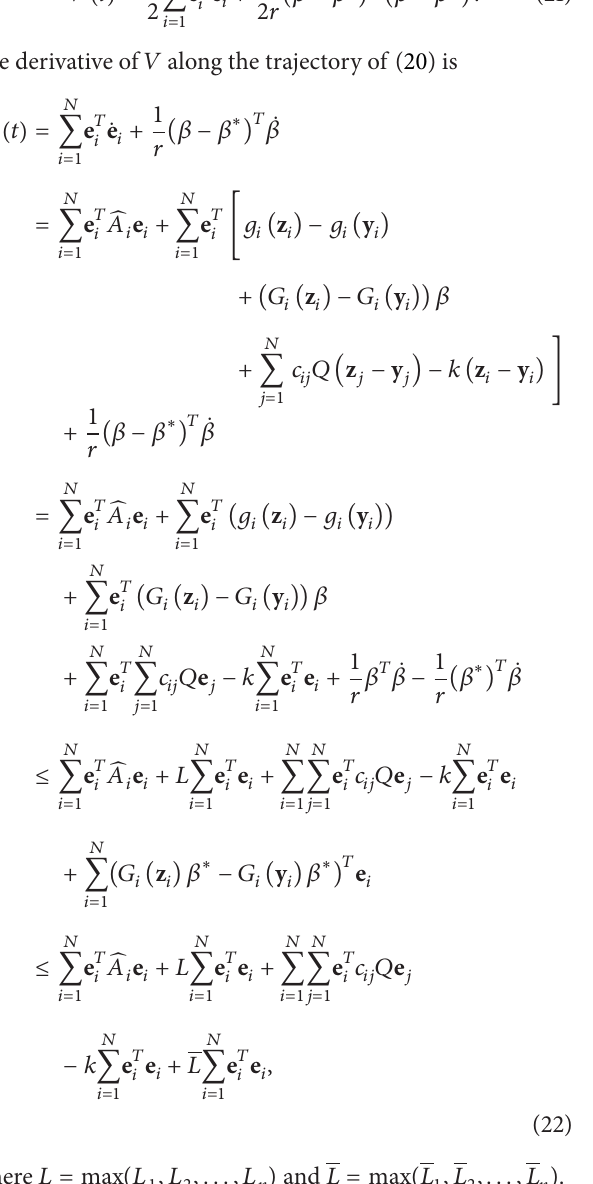
Figure 8: GOS error with different node dynamics, where the node dynamics in the drive and response networks are the Lorenz and Chen systems with unknown parameters, respectively. Here,